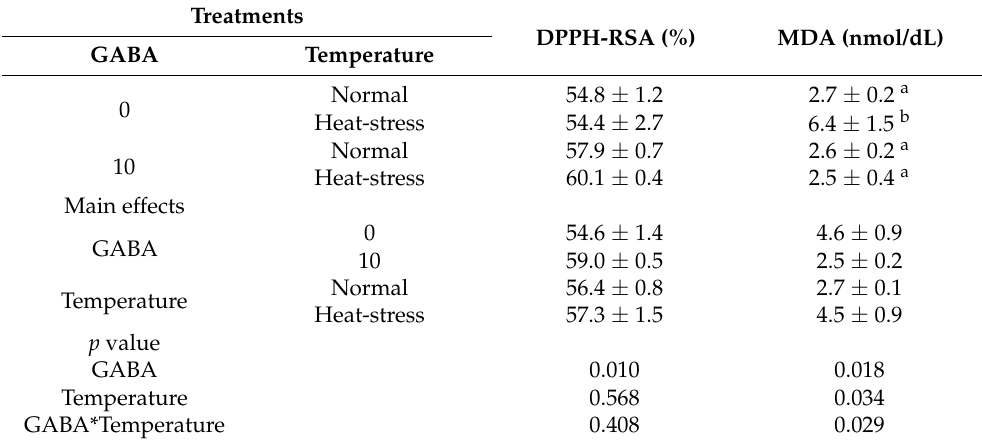
Table 7. Effect of in ovo injection of GABA on plasma oxidative stress markers of 10-day-old chicks exposed to acute heat stress for 3